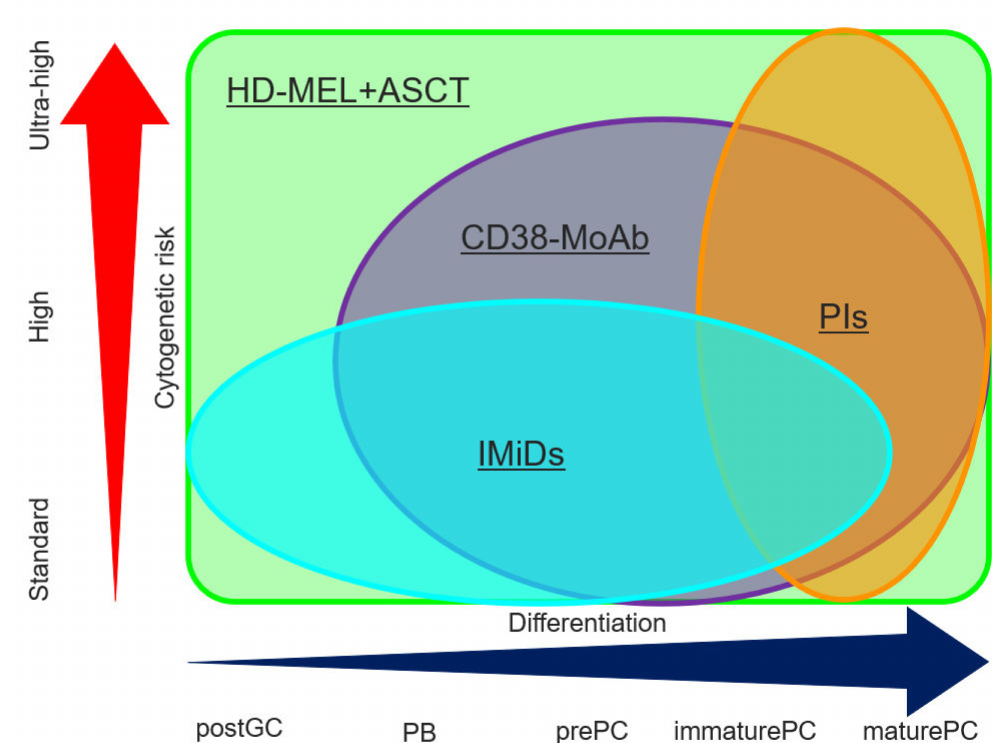
Figure 2. Activity of PIs, IMiDs, CD38 MoAB, and ASCT in terms of the differentiation of MM cells and cytogenetic risk. PIs contribute to anti-myeloma activity in more mature MM cells relatively independent from cytogenetic risk. IMiDs attack immature MM cells, but this is not enough to treat high-risk cytogenetic abnormality. CD38 MoAb can be used for CD38- positive MM cells excluding post GC cells and improves clinical outcome in the patients with HRCA through long-interval administration. A high dose of melphalan followed by ASCT kills MM cells independent of the differentiation of MM cells and cytogenetic risk. PIs, proteasome inhibitors; IMiDs, immunomodulatory drugs; MoAbs, monoclonal antibody agents; HD-MEL + ASCT, high dose melphalan followed by autologous stem cell transplantation; postGC, post germinal center; PB, plasmablast; PC, plasma